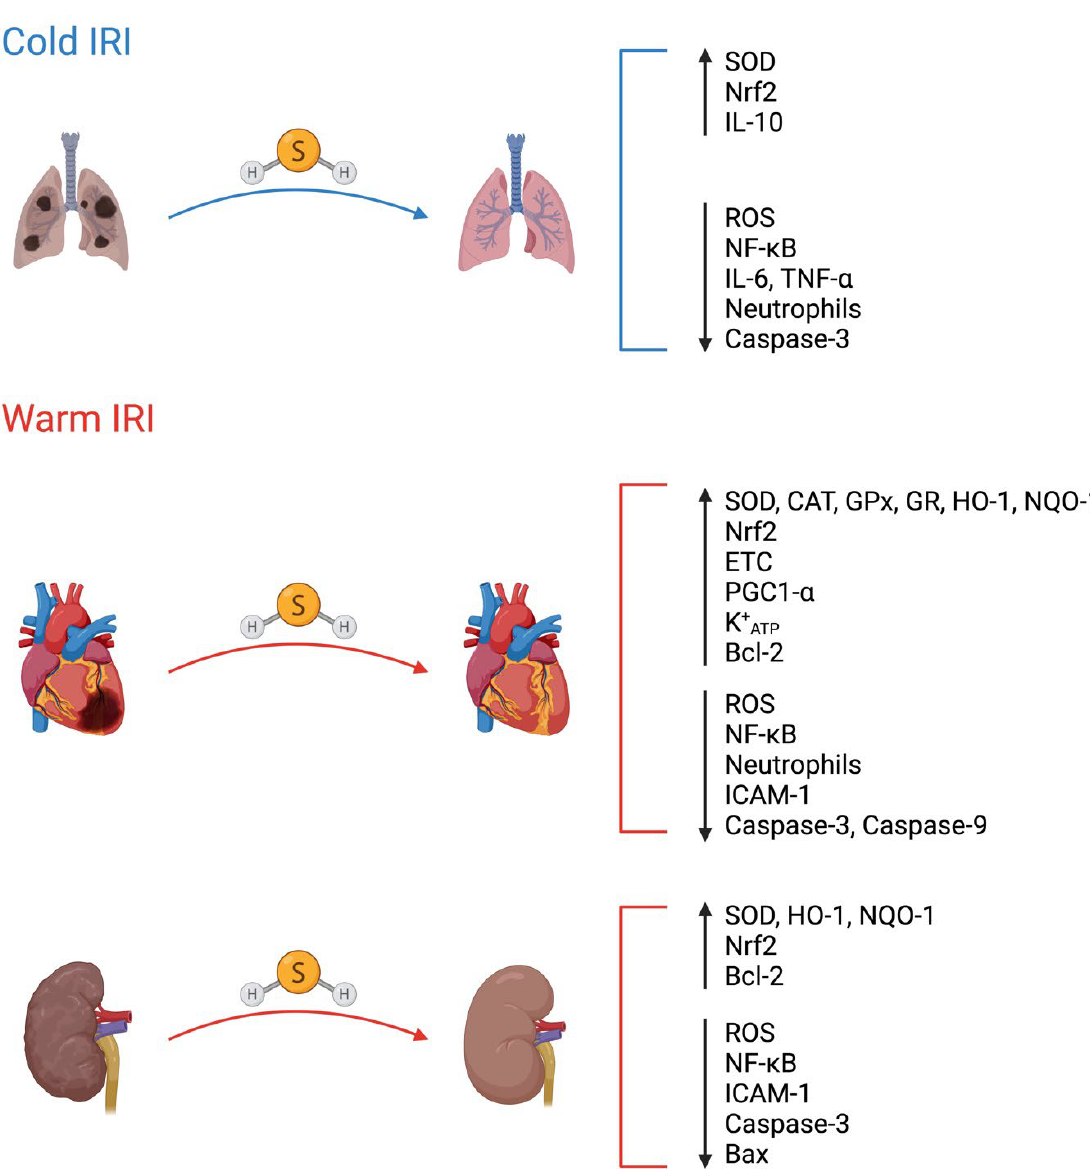
Figure 2. Molecular targets of H 2 S pre-treatment in cold and warm IRI. Hydrogen sulfide (H 2 S) pre-treatment regimens may protect against IRI by modifying different molecular targets. SOD: superoxide dismutase; Nrf2: nuclear factor erythroid 2-related factor 2; IL-10: interleukin-10; ROS: reactive oxygen species; NF- κ B: nuclear factor kappa-light-chain-enhancer of activated B cells; IL-6: interleukin-6; TNF- α : tumor necrosis factor-alpha; CAT: catalase; GPx: glutathione peroxidase; GR: glutathione reductase; HO-1: heme oxygenase-1; NQO-1: NADPH quinone oxidoreductase-1; ETC: electron transport chain; PGC1- α : peroxisome proliferator-activated receptor gamma coactivator 1-alpha; K + ATP : adenosine triphosphate-sensitive potassium channel; Bcl2: B-cell lymphoma-2; ICAM-1: intercellular adhesion molecule-1; Bax: Bcl-2 associated X-protein. H 2 S is represented as a ball-and-stick model (sulfur in yellow; hydrogen in white; covalent bonds in grey). Figure created with BioRender.com.